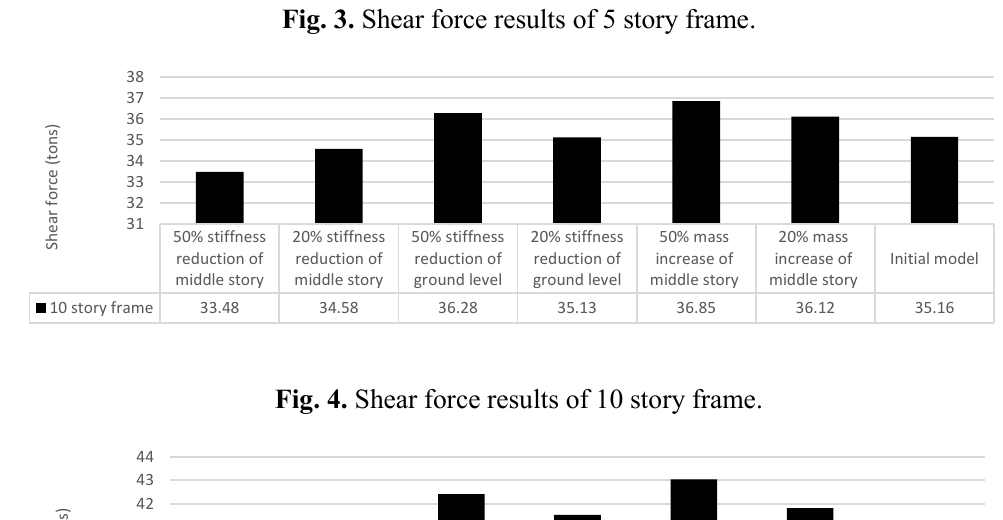
Fig. 3. Shear force results of 5 story frame.